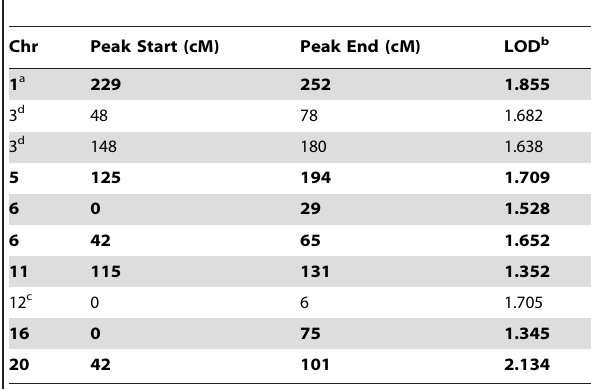
Table 1. QTLs shared by camptothecin